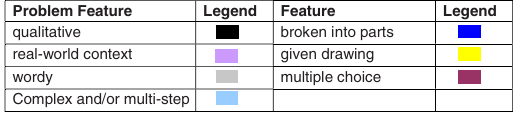
FIG. 3. (cid:1) Color (cid:2) Legend for problem features in Figs. 4–10.